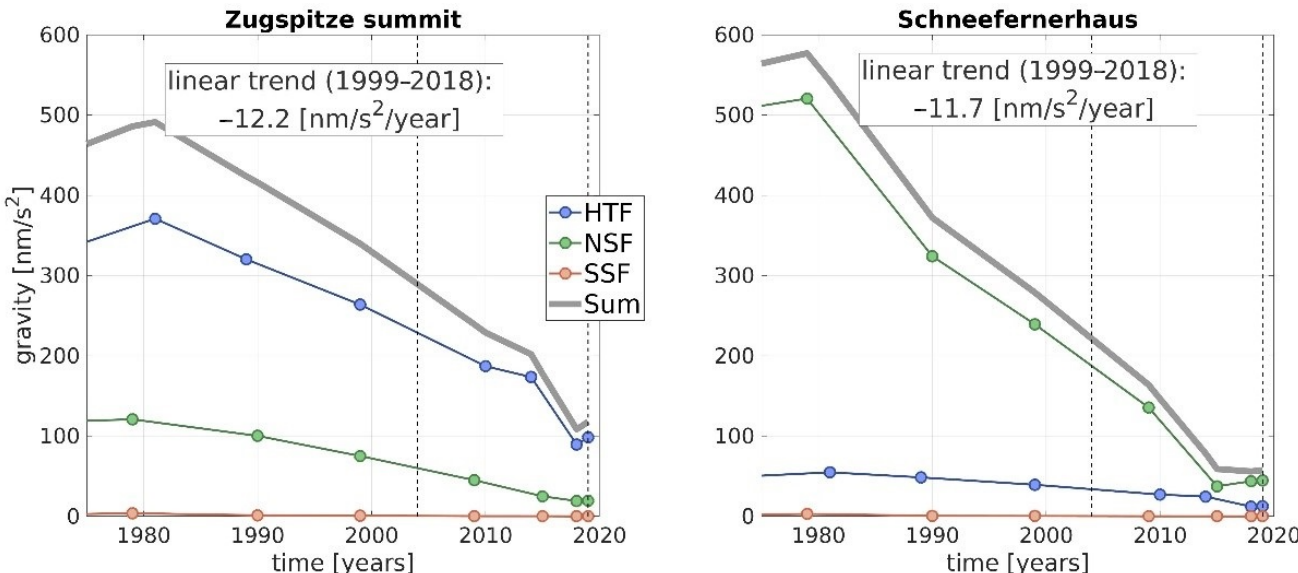
Figure 10. Gravity effect of glacier masses of Höllentalferner (HTF), Nördlicher Schneeferner (NSF) and Südlicher Schneeferner (SSF) evaluated at Zugspitze summit (left panel) and Schneefernerhaus (right panel). Dashed vertical lines indicate epochs of absolute gravity observations.